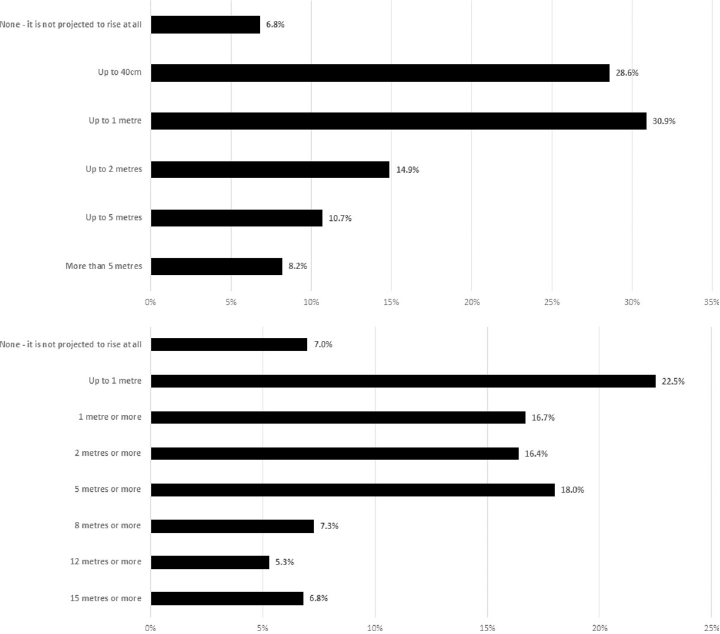
Fig 1. Sea-level rise projections to 2100. (a): Respondents were asked ‘How much do you think global sea level is projected to rise by 2100?’ (b): Respondents were asked ‘How much could global average sea level rise under ‘a scientifically credible worst-case